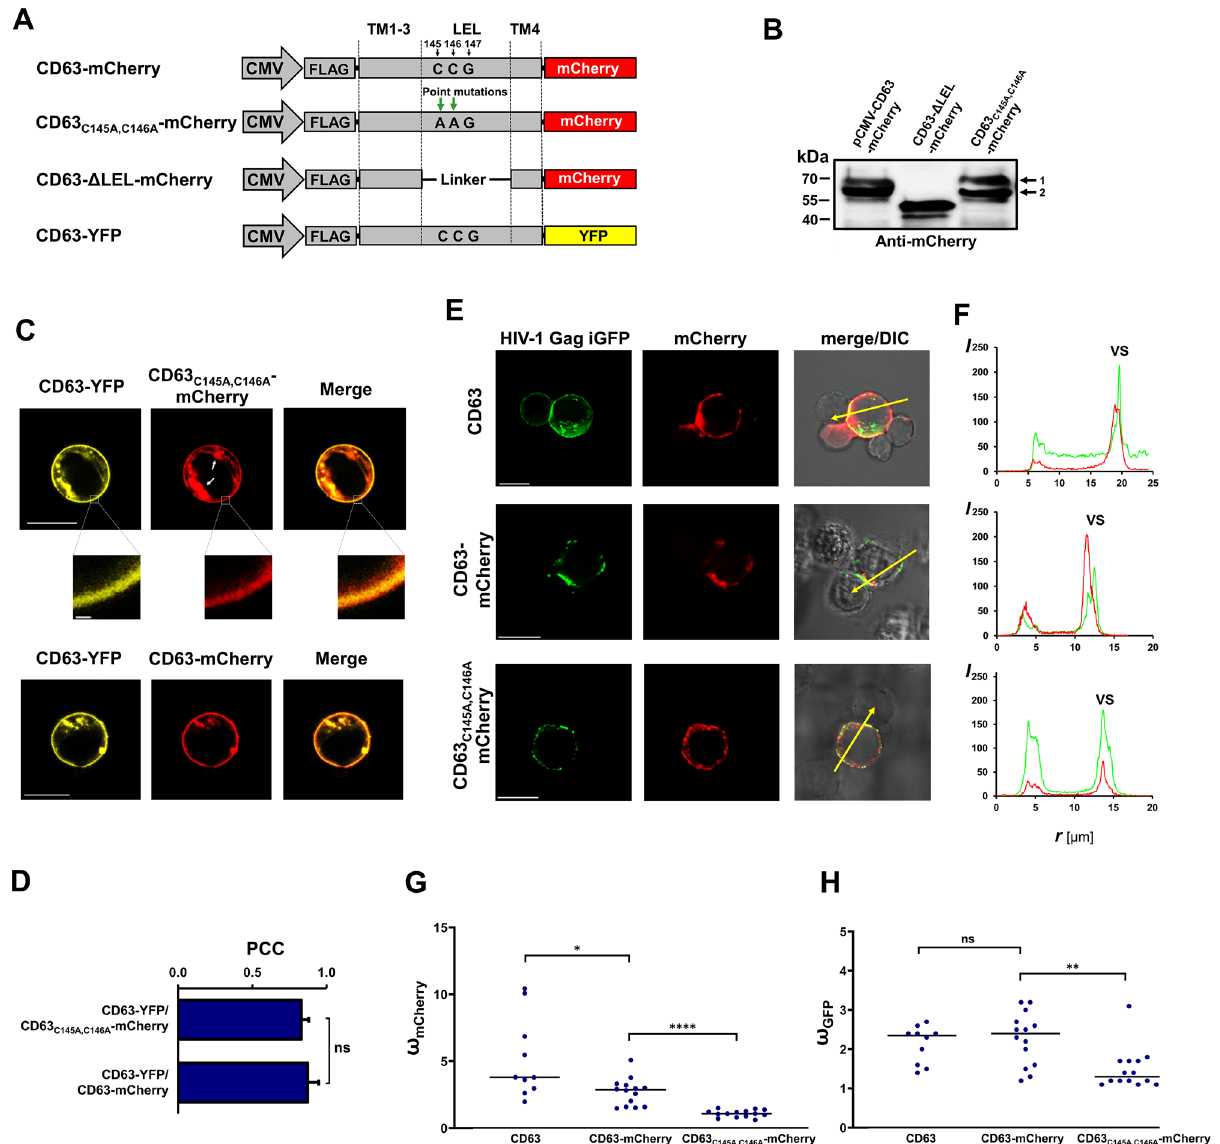
Figure 6. Influence of cysteine mutations within the LEL on the CD63 and HIV-1 JR-FL Gag-iGFP recruitment to the VS. ( A ) A schematic representation (not to scale) of the fused mCherry or YFP CD63 expression constructs, numbers refer to the amino acid sequence. ( B ) Western blot analysis of transfected HEK293T cells with constructed vector. Molecular weight of glycosylated CD63 (1) and CD63 backbone (2) is marked with a black arrow. ( C ) Colocalization of expressed CD63 variants, arrows point to observed higher intracellular protein localization, cut-out shows colocalization details at the plasma membrane. ( D ) Calculated Pearson coefficients of correlation (PCC) for n = 11 cells are graphed. ( E ) Confocal images of Jurkat cells transfected with HIV- 1 JR-FL Gag-iGFP and (second and third row) with pCMV-CD63-mCherry or pcmv-CD63 C145A C146A -mCherry. Jurkat cells were indirectly stained with anti-CD63 antibodies (first row) in order to visualize endogenous CD63 expression. The yellow arrow indicates the region for which the fluorescence intensity ( I ) was measured. ( F ) The I values for GFP and mCherry are displayed as a function of the distance. Quantification of recruiting ( G ) CD63 and ( H ) Gag proteins to the VS by calculation of the recruiting factor ω was dependent on mCherry or GFP obtained from n = 14 (CD63-mCherry-FLAG, CD63C 145A,C146A -mCherry-FLAG) and n = 10 (CD63 independent cell–cell contacts from Jurkat cells measured from three positions within each cell, mean values are displayed as dots. All scale bars are 10 µm, except in ( C ), where they are 0.5